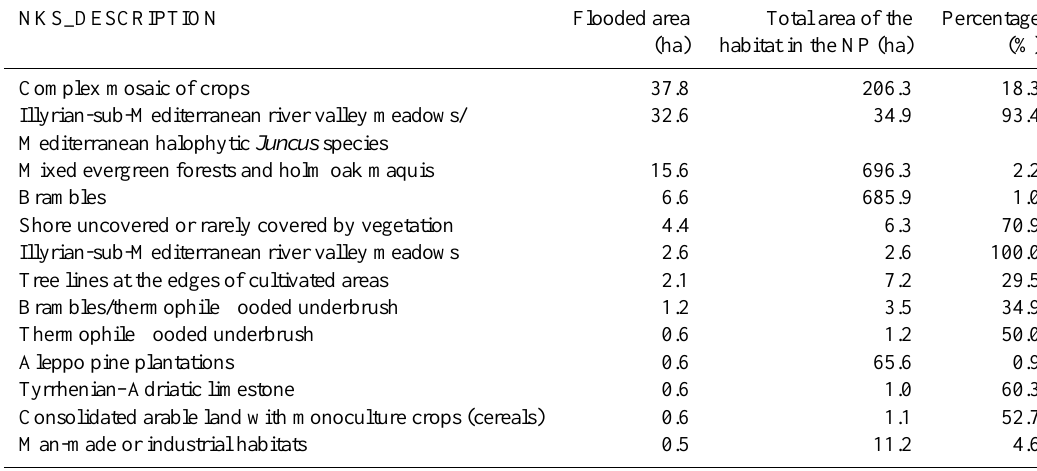
Table 6. Perimeter and surface area of Lake Vrana at various water levels, for the most suitable (OCK) interpolation method. Water level (in reference to the Prosika gauge) Perimeter (km)